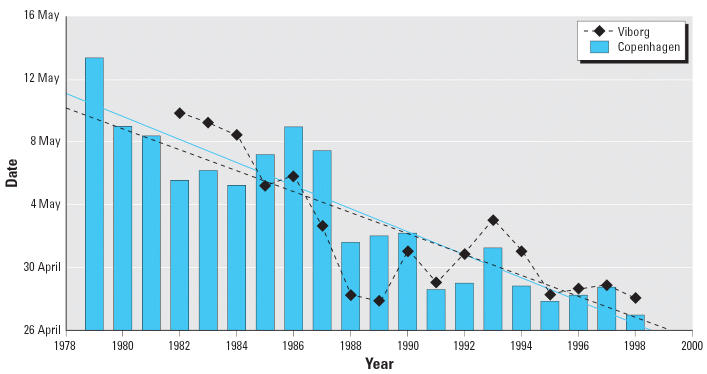
Peak date of airborne birch (Betula) pollen concentrations in Denmark, 1978–1999. Viborg: Ym = 122.1; β = −0.67; r = −0.81; p < 0.001. Copenhagen: Ym = 123.3; β = −0.74; r = −0.92; p < 0.001. Adapted from Rasmussen (2002).